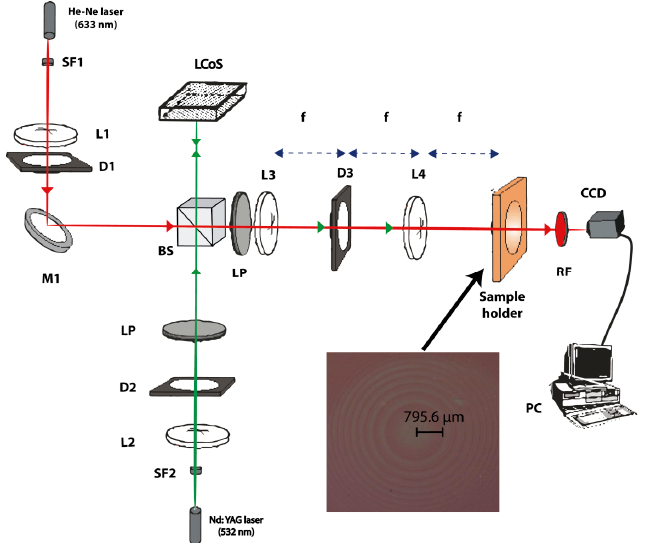
Figure 1. Experimental setup used to register and analyze in real-time the DOEs (diffractive optical elements, diffractive lenses) D: diaphragm; L: lens; BS: beam splitter; SF: spatial filter; LP: lineal polarizer; M: mirror; RF: red filter.